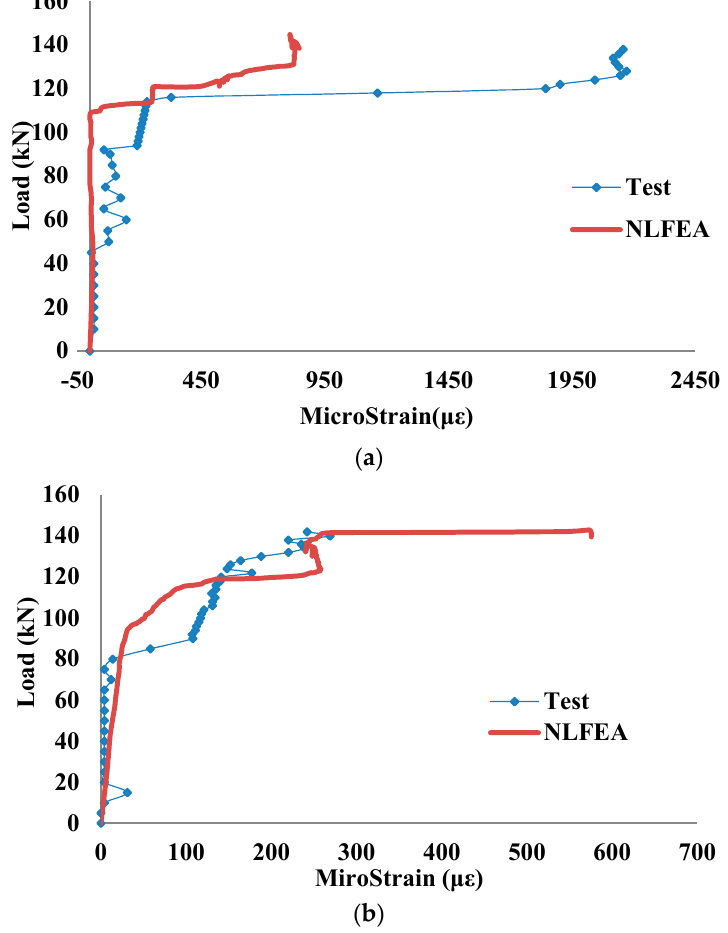
Figure 20. Comparison of load vs. strain in deep embedment strengthening bars: ( a ) Test model coded as S-C-2-9; ( b ) Test model coded as S-C-1-9.